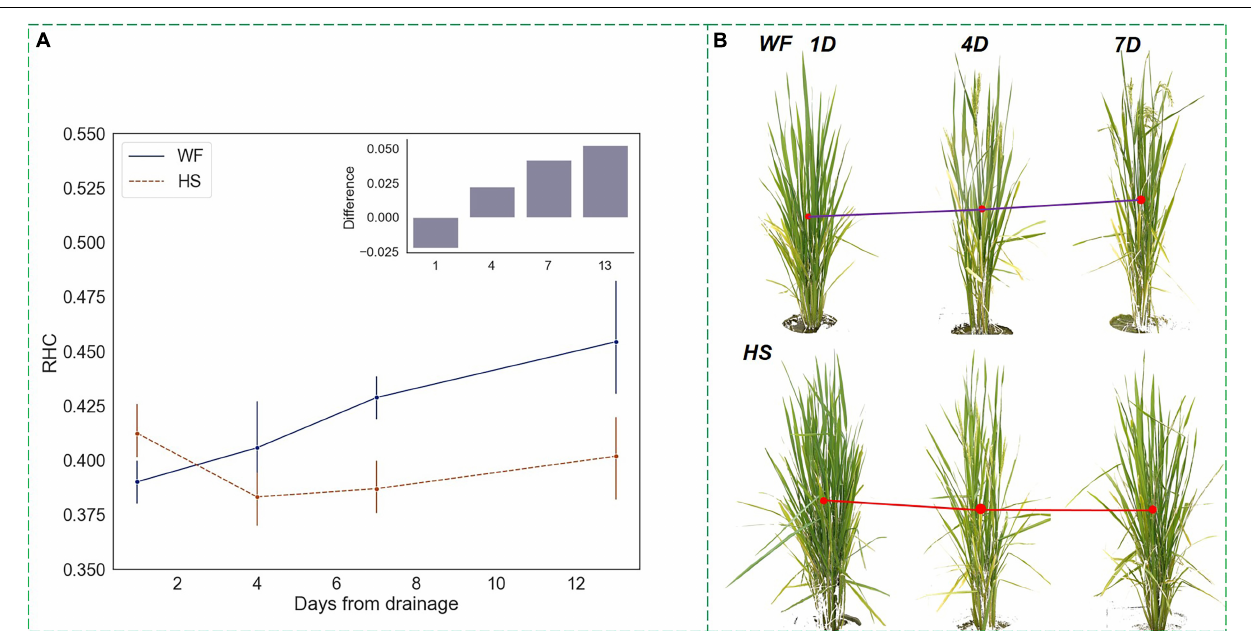
FIGURE 8 | Changing trends of RHC under short-term water stress at the heading stage. (A) RHC trends and differences. (B) Changes in the front-view images of rice 7 days after drought. The blue line (upper) represents the RHC of plants in the WF group, while the red line (lower) represents the RHC of plants in the HS group. The y -axis of the histogram represents the difference between RHC of the WF group minus that of the HS